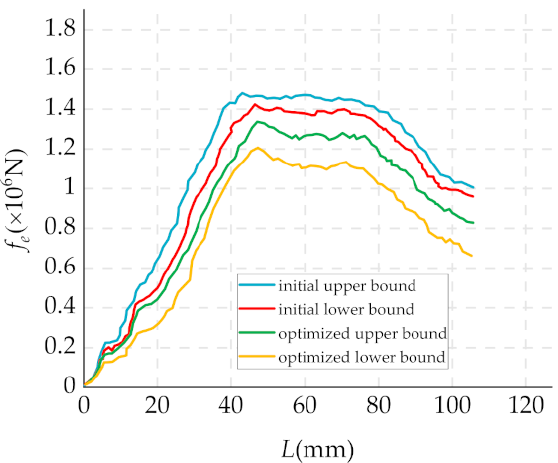
Figure 22. The initial and optimized interval of the engraving resistance force.